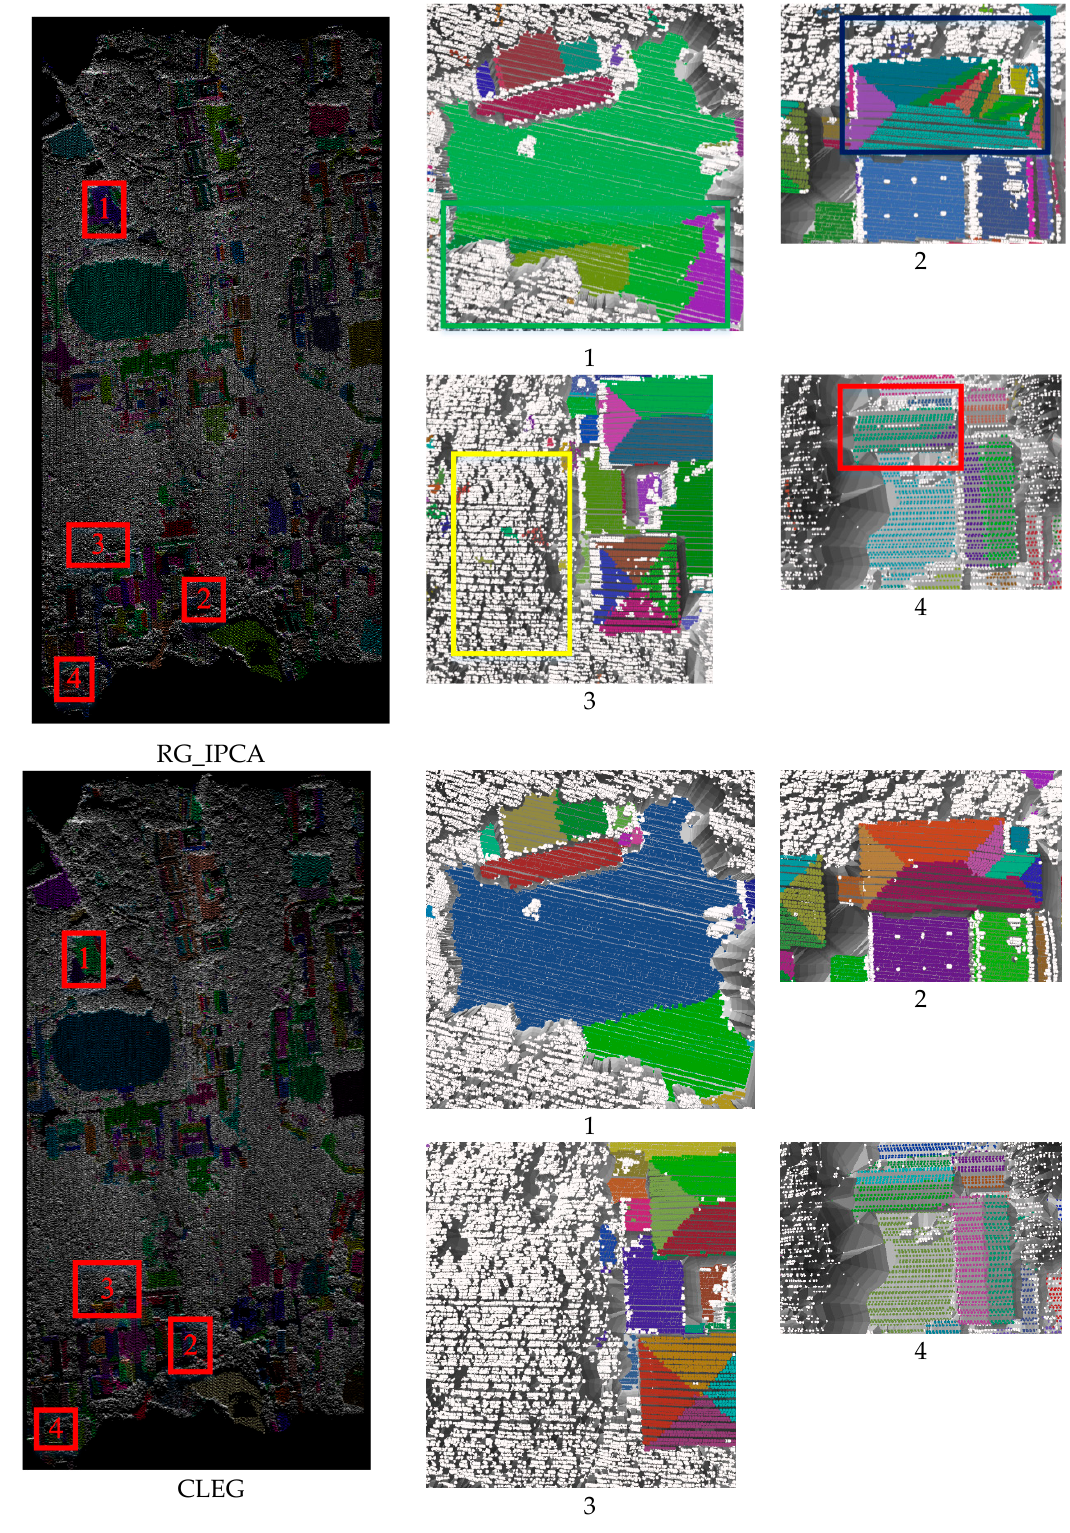
Figure 16. Segmentation results in the Wuhan area using dataset (e).